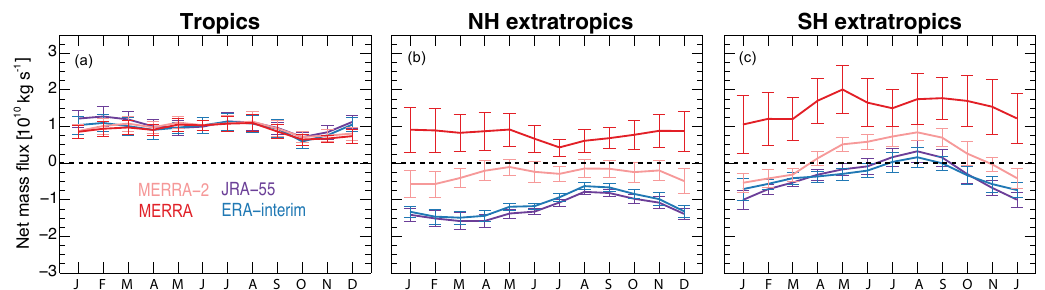
Figure 12. The same as in Fig. 11 but for the (a) tropics, (b) NH extratropics, and (c) SH extratropics.